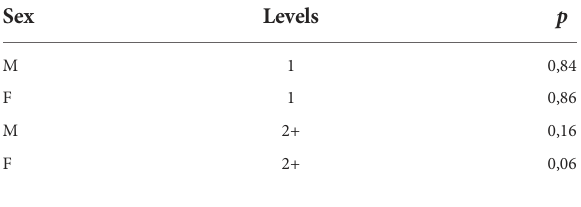
TABLE 4 Resulting p -values when testing for equal blood loss distributions for NSAID and non-NSAID patients in the four different subgroups formed by sex and (aggregated) number of segments.